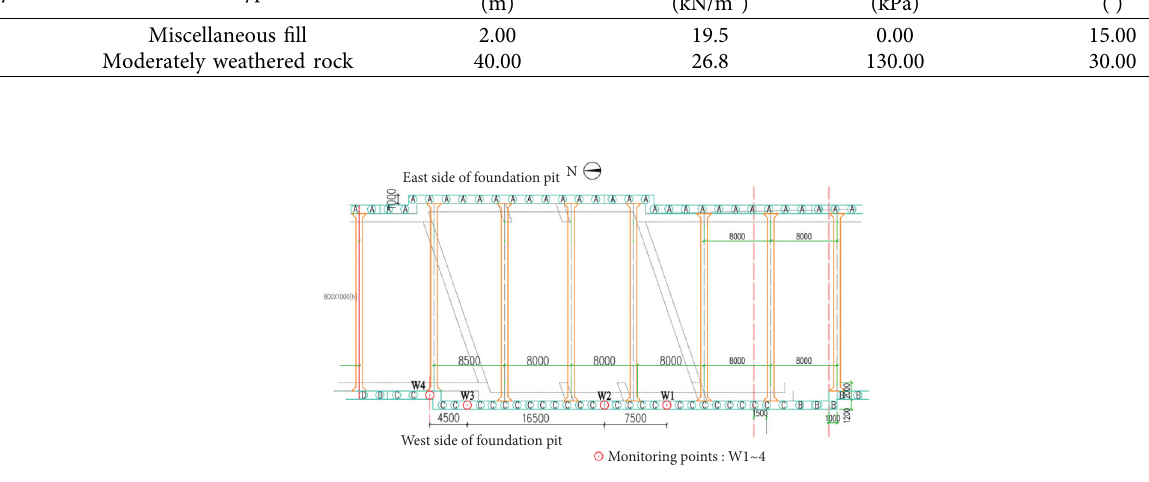
Figure 12: Monitoring points for retaining piles (unit: